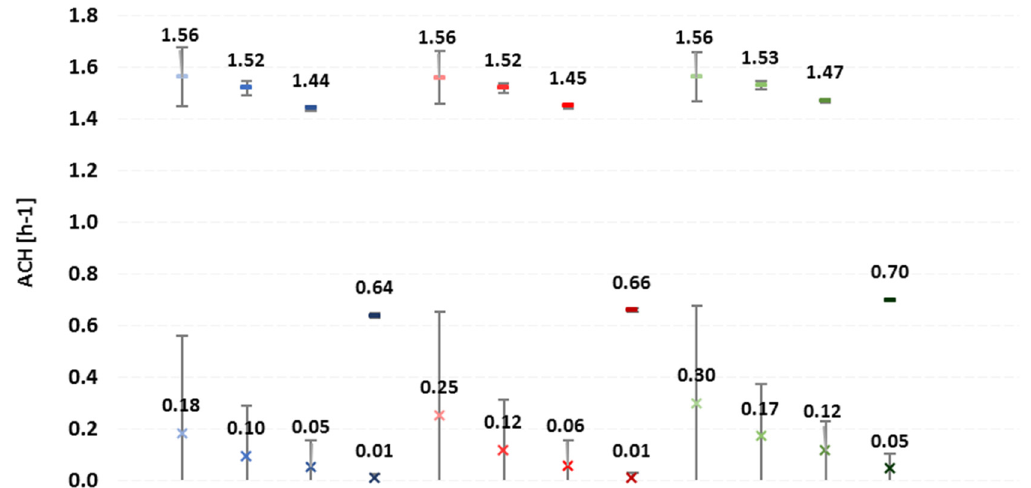
Figure 8. Average (labels) and standard deviation of ACH values: MEV on (dash)–MEV off (cross); scenarios—1 (blue), 2 (red), 3 (green); lighter to darker colour grade with increasing airtightness levels.